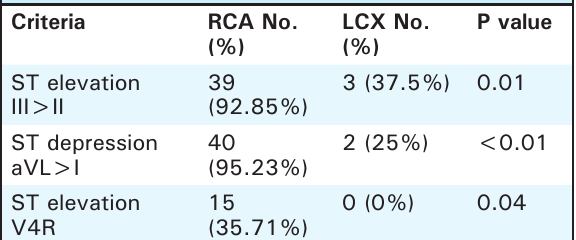
Table 4. Comparison of ECG criteria between RCA and LCX group.